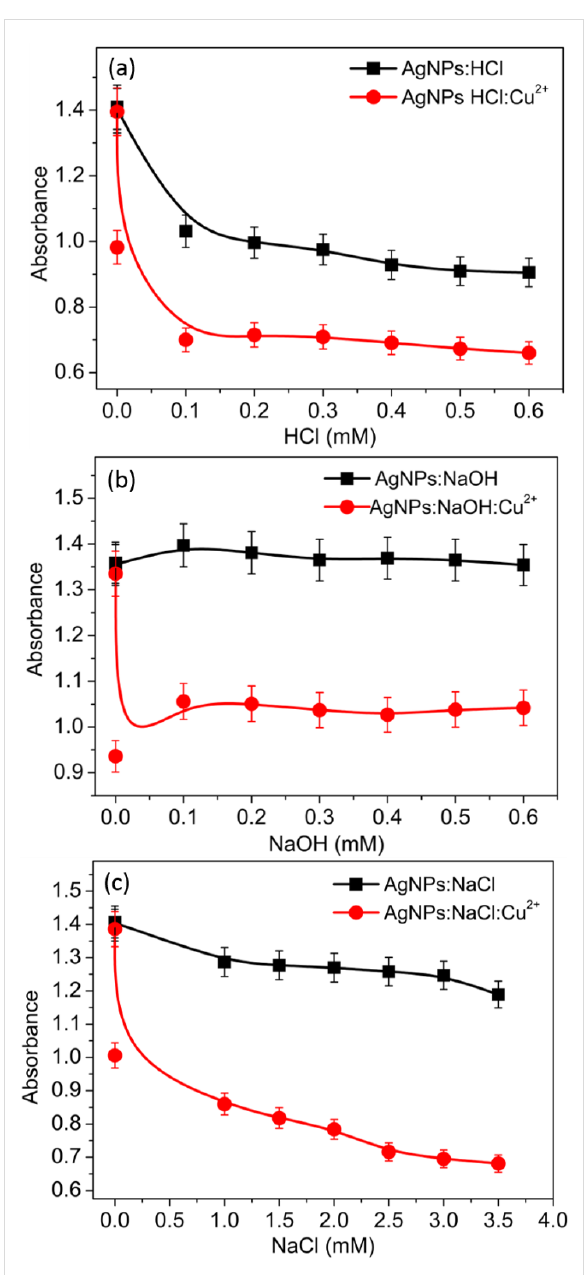
Figure 4: Absorbance intensity (at 410 nm) of the proposed probe in the presence and absence of Cu 2+ at different (a) HCl concentrations, (b) NaOH concentrations and (c) ionic